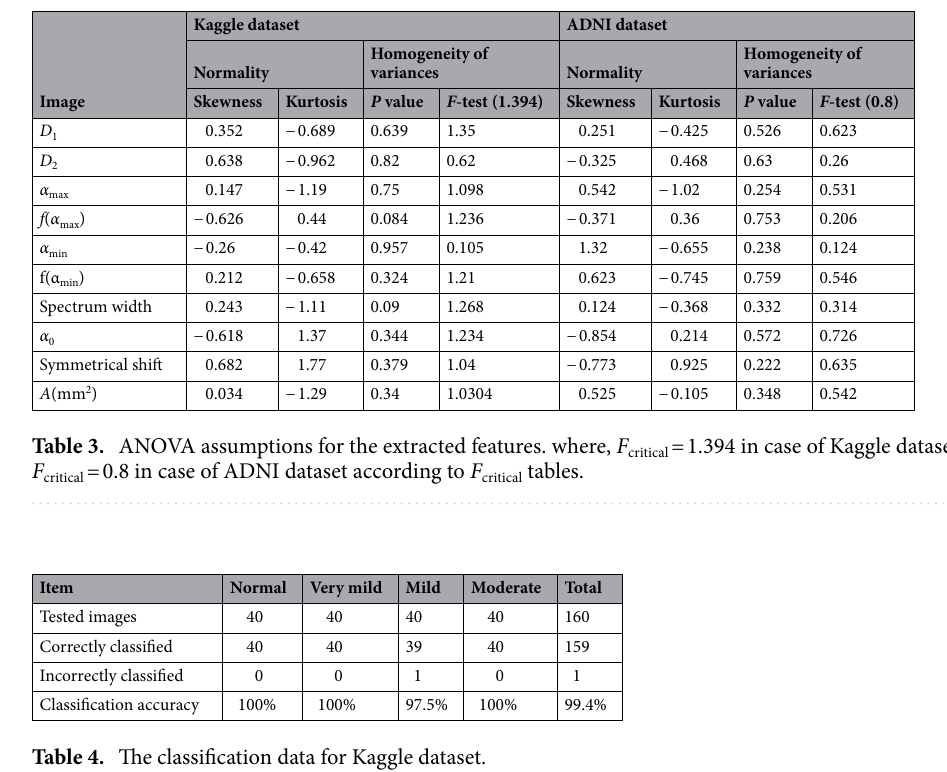
Table 4. The classification data for Kaggle dataset.